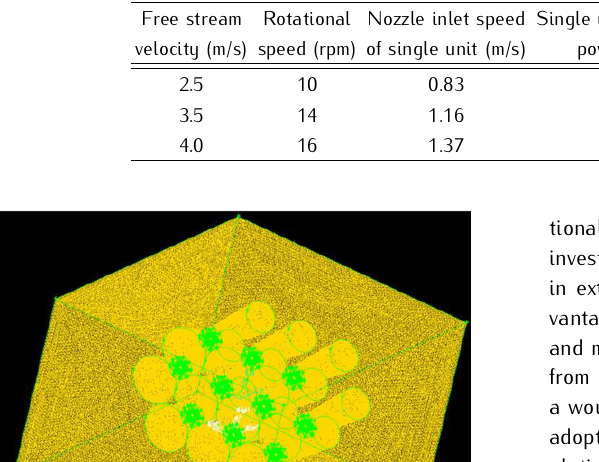
Table 3. Extracted power variation with inlet velocity.